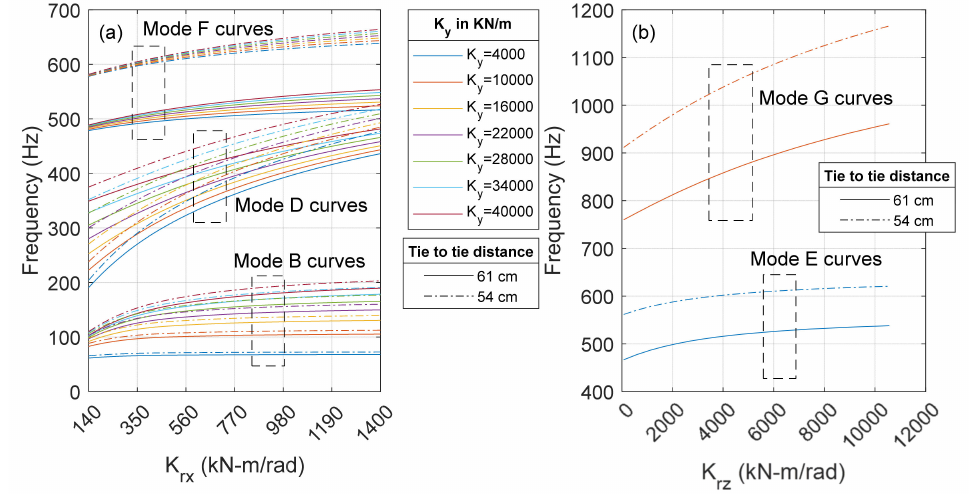
Figure 6. Sensitivity analysis. Effect of tie-to-tie distance on the resonant frequency of ( a ) modes B, D and F for different values of K y and K rx , and ( b ) modes E and G for a range of K rz coefficients.